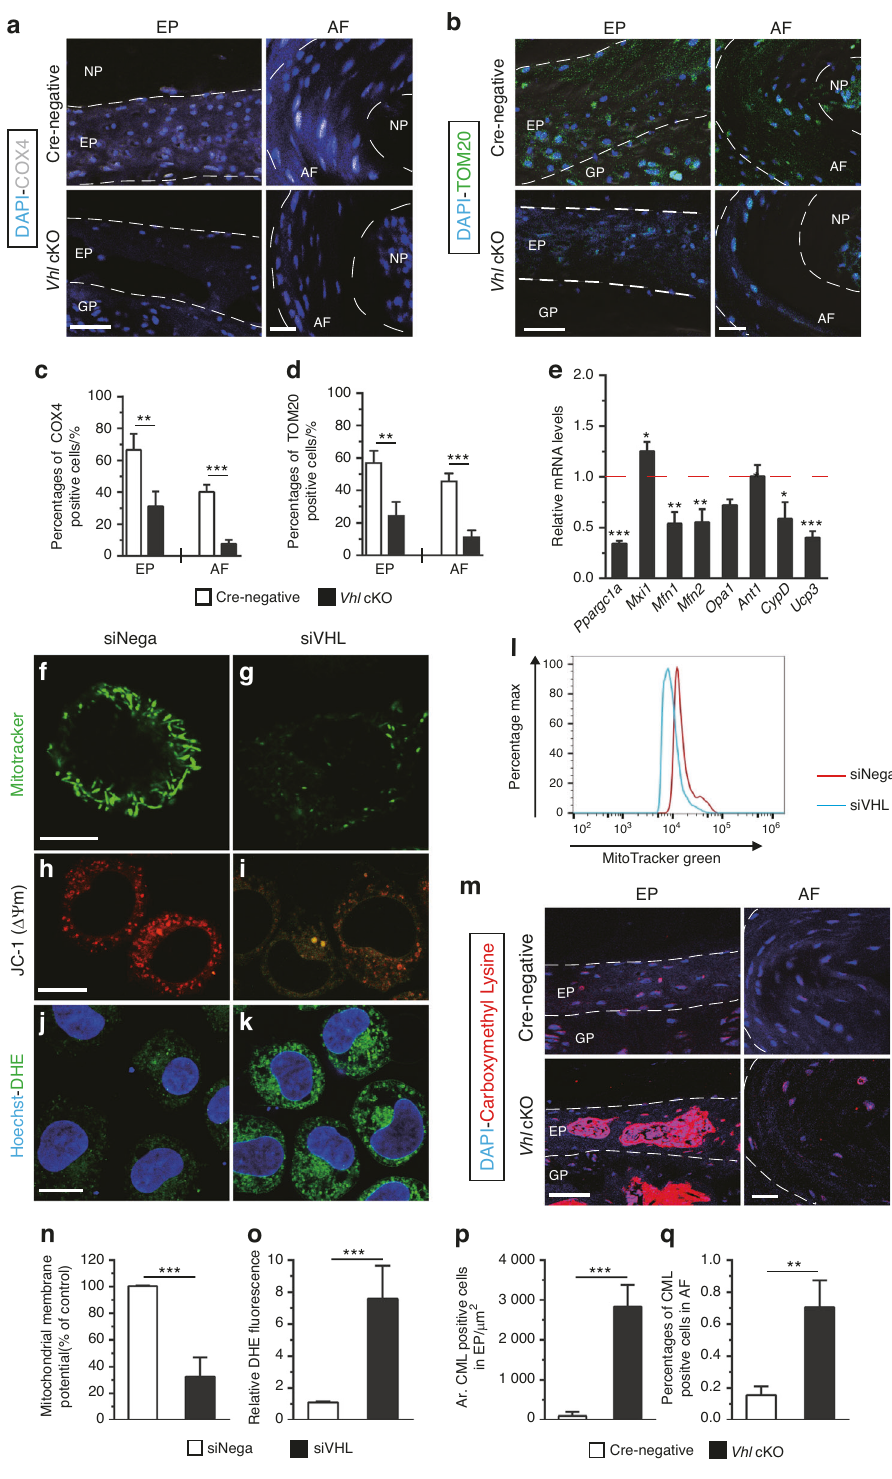
Fig. 6 Aberrant HIF1 α signaling causes mitochondrial dysfunction. a , b Immuno fl uorescence detection of COX4 and TOM20 was performed in lumbar discs of WT and Vhl cKO mice ( n = 3 per group). c , d Percentages of COX4- and TOM20-immunoreacted positive cells. e RCS cells were transfected with siRNA-Vhl (RCS-siRNA-Vhl). Total RNA was isolated, and the mRNA levels of Ppargc1a , Mxi1 , Mfn1 , Mfn2 , Opa1 , Ant1 , CypD , and Ucp3 were detected by RT-PCR ( n = 3 per group). f , g Fluorescent staining for monitoring mitochondria with a MitoTracker ® probe. (h-i) RCS cells subjected to siRNA-Vhl were stained with JC-1. Changes in △ Ψ m were detected by fl uorescence microscopy. ( j , k ) ROS production was determined using the fl uorescent probe dihydroethidium (DHE) (green: DHE; blue: Hoechst) ( n = 3 – 4). l Quanti fi cation of fl ow cytometry for mitochondrial mass. m Carboxymethyl lysine (CML) signals were analyzed by an immuno fl uorescence assay from WTand Vhl cKO mice at the age of 12 months (red: anti-CML; blue: Hoechst) ( n = 3 – 4). n Quanti fi cation of mitochondrial membrane potential, o DHE fl uorescence, p areas